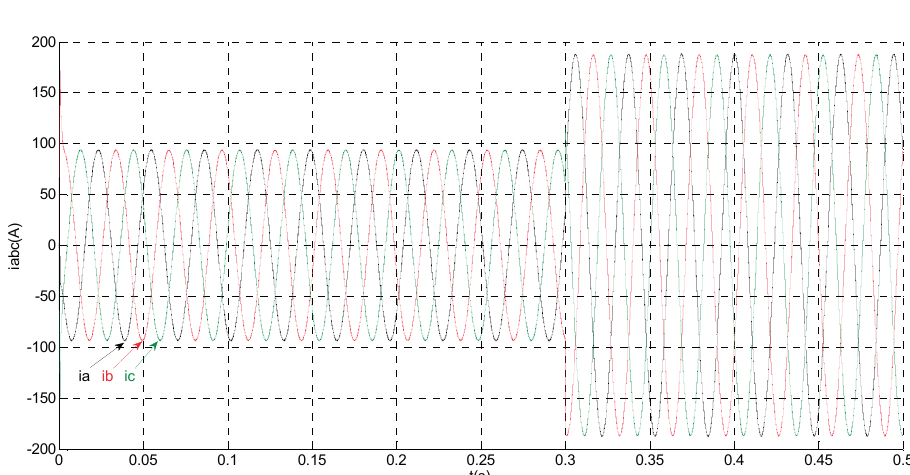
Figure 3. Simulation result of electromagnetic torque.